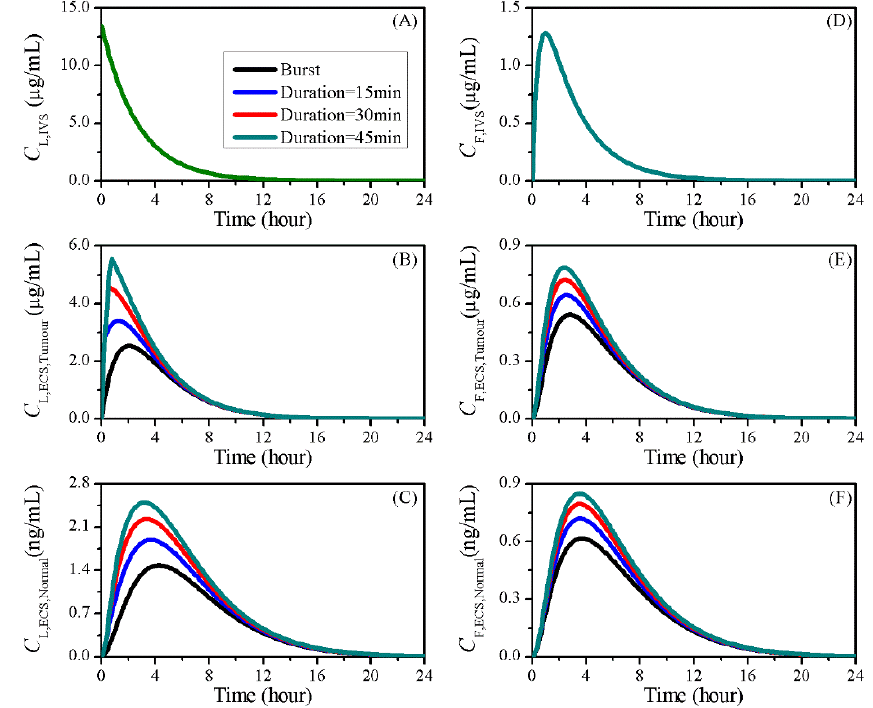
Figure 12. The time courses of doxorubicin concentrations in treatments with different sonication durations. Liposome-encapsulated doxorubicin in ( A ) IVS, ( B ) tumour and ( C ) normal tissue ECS; free doxorubicin in ( D ) IVS, ( E ) tumour and ( F ) normal tissue ECS.